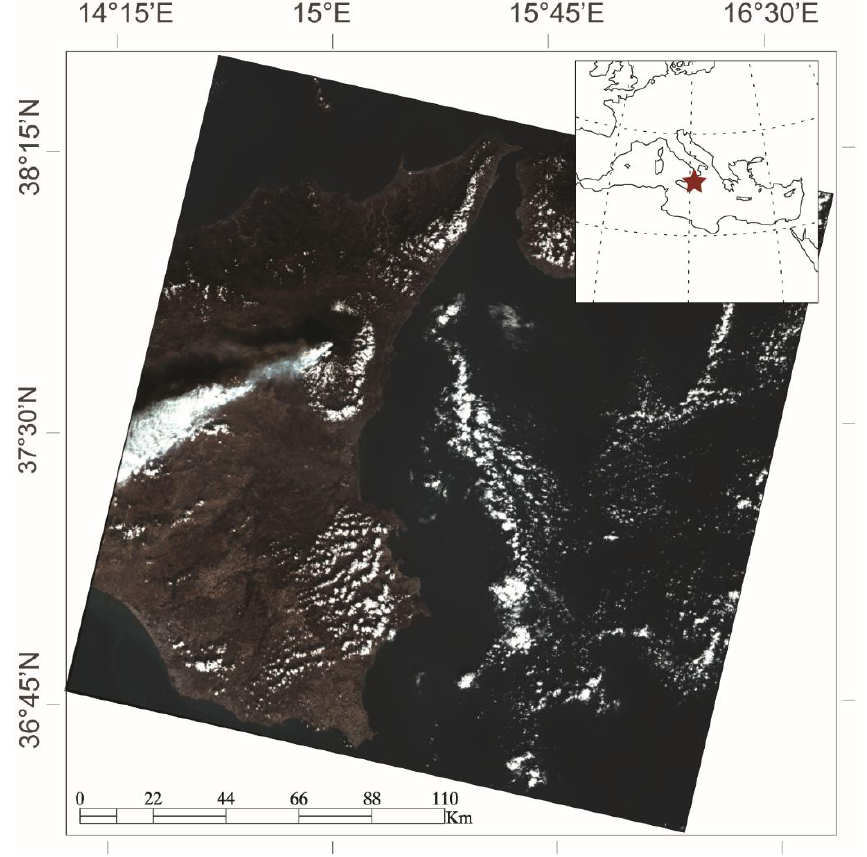
Figure 1. Orthorectified Landsat 8 data acquired the 26 October 2013 at 09:37 UTC on Mt. Etna volcano (image courtesy of National Aeronautics and Space Administration (NASA)/United States Geological Survey (USGS)).